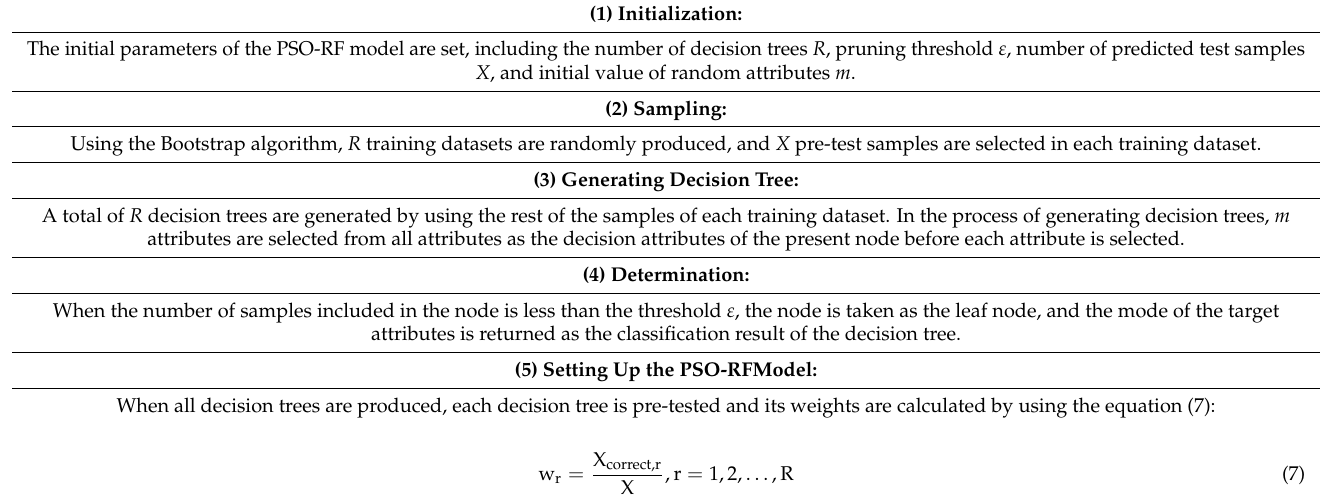
Table 4. The main steps of the particle swarm optimization random forest (PSO-RF)